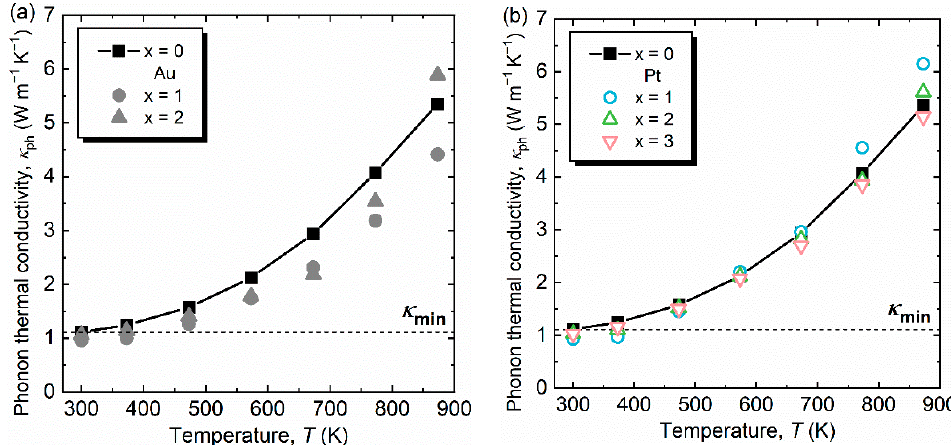
Figure 5. Phonon thermal conductivity κ ph as a function of temperature for ( a ) Al 63 Cu 25 − x Au x Fe 12 ( x = 0, 1, 2) and ( b ) Al 63 Cu 25 − x Pt x Fe 12 ( x = 0, 1, 2, 3). The dashed lines represent the minimum thermal conductivity κ min for Al 63 Cu 25 Fe 12 .